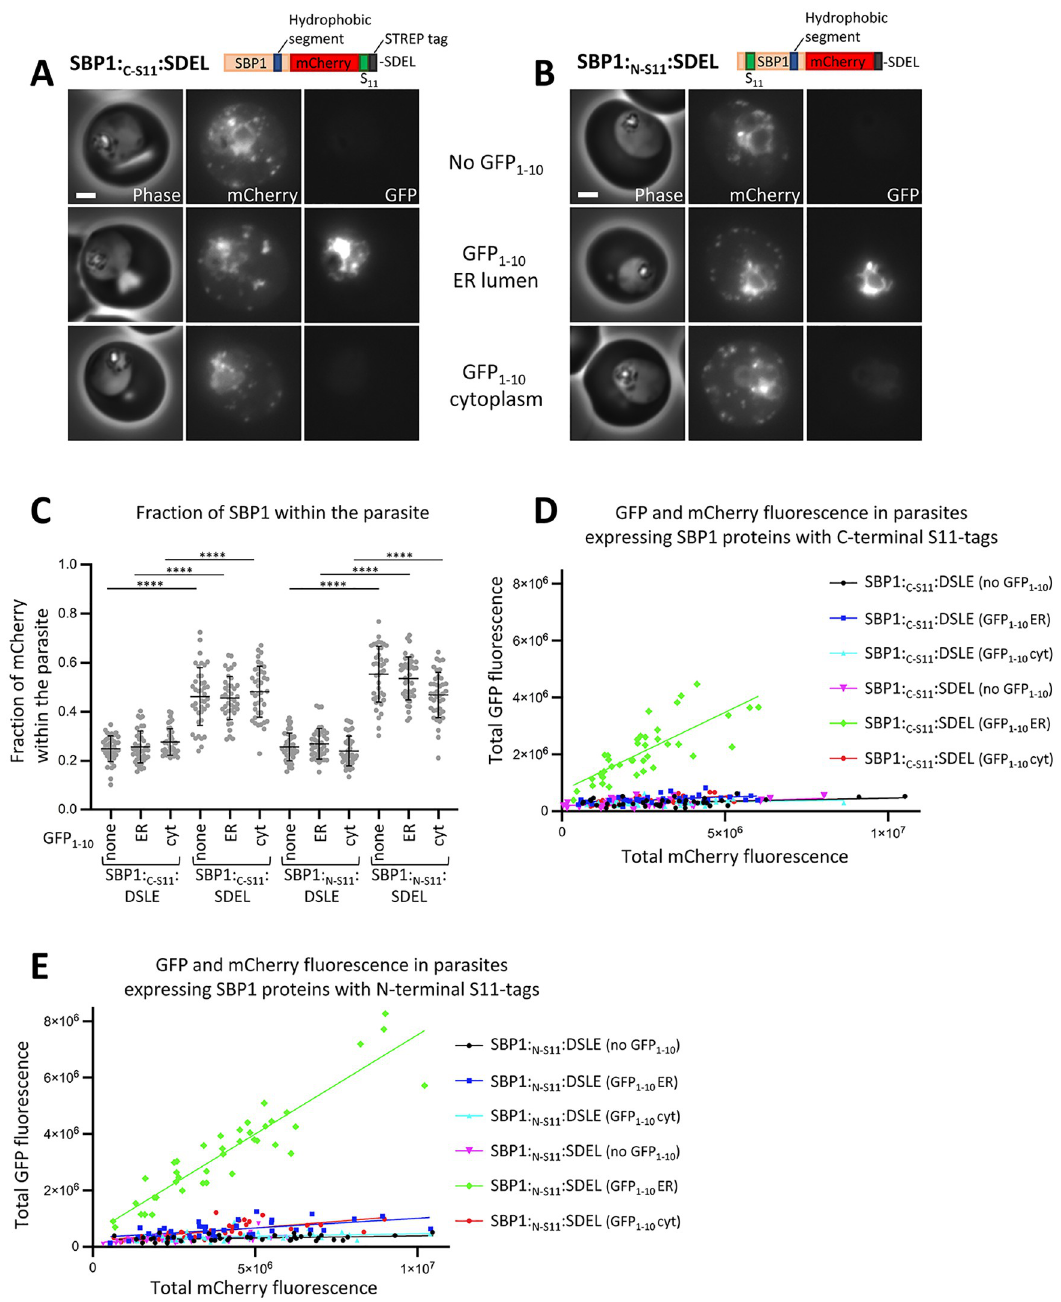
Fig 5. Export of SBP1 is perturbed by a C-terminal ER-retention sequence. (A-B) Phase contrast and fluorescence images of parasites expressing the indicated proteins are shown. Proteins were expressed alone, co-expressed with ER-lumenal GFP 1-10 or cytoplasmic GFP 1-10 , as indicated. Scale bar: 2 μ m. (C) The fraction of total mCherry fluorescence located within the parasite is shown for parasite lines expressing the indicated SBP1 and GFP 1-10 proteins. Forty individual trophozoite stage parasites, from two independent experiments, were analysed for each parasite line. Data points for individual parasites, mean and standard deviation are shown. P-values were determined using a one-way ANOVA test, P < 0.0001 = **** . (D-E) For parasites expressing the indicated SBP1 proteins, the total mCherry fluorescence and total GFP fluorescence levels are plotted (for both channels this corresponds to the fluorescence in the infected red blood cell and the parasite). Forty individual trophozoite stage parasites, from two independent experiments, were analysed for each parasite